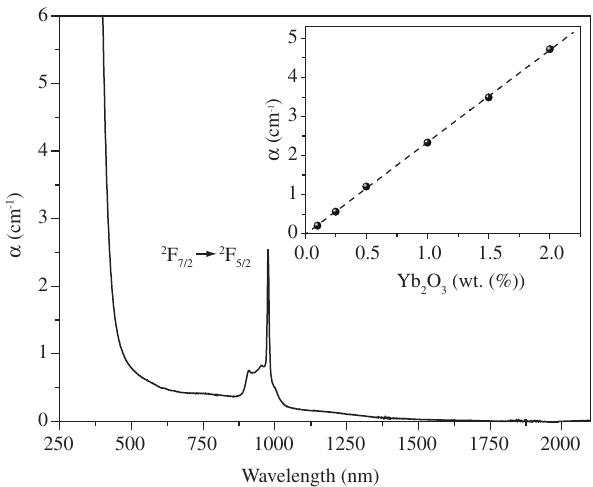
Figure 3. Near infrared luminescence spectrum for GP glass with 2.0 wt. (%) O of 2 3